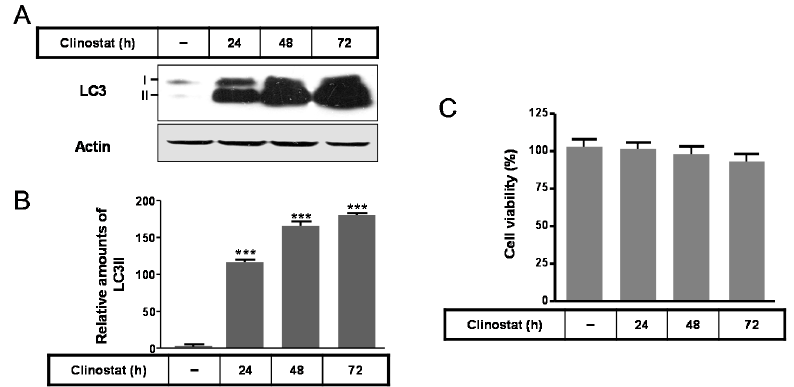
Figure 1. Expression of the microtubule-associated protein light chain (LC3) protein with clinostat rotation in MC3T3-E1 cells. MC3T3-E1 cells were incubated in α -minimum essential medium ( α -MEM) added with 10% fetal bovine serum (FBS) and 1% Penicillin-Streptomycin (PS) at 37 °C with 5% CO 2 . To experimentally simulate microgravity with the 3D clinostat, cells were cultured in T-25 cell culture flasks completely filled with a 1:1 mixture of α -MEM and Leibovitz’s L-15 supplemented with 10% FBS and 1% PS. LC3 expression was then performed by Western blot analysis ( A ); The relative expression of LC3 ( B ) was quantified and cell survival ( C ) was carried out as described in the Materials and Methods section. Values in representative results are shown as means ± SD of at least three independent experiments. *** p < 0.001 vs. no clinostat.